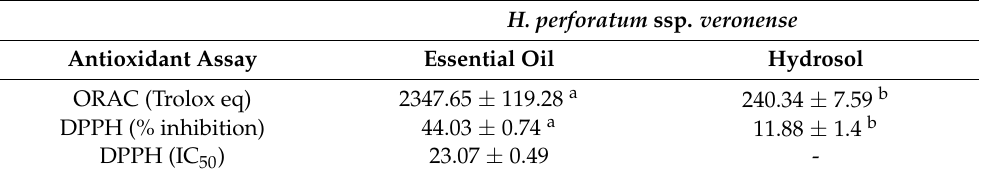
Table 2. Antioxidant potential of Hypericum perforatum ssp. veronense essential oil and hydrosol determined by ORAC and DPPH